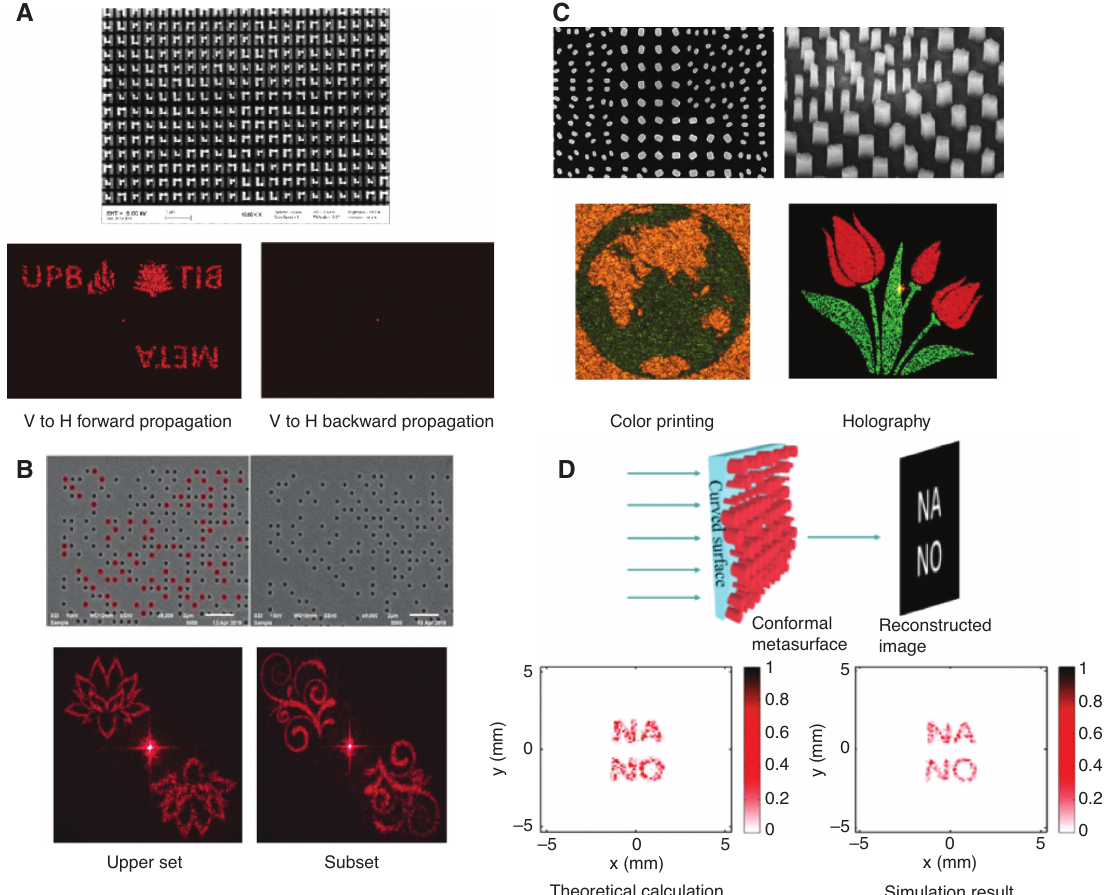
Figure 2: The integration between metasurface holography and asymmetric transmission, amplitude modulation, spectral responses and conformal